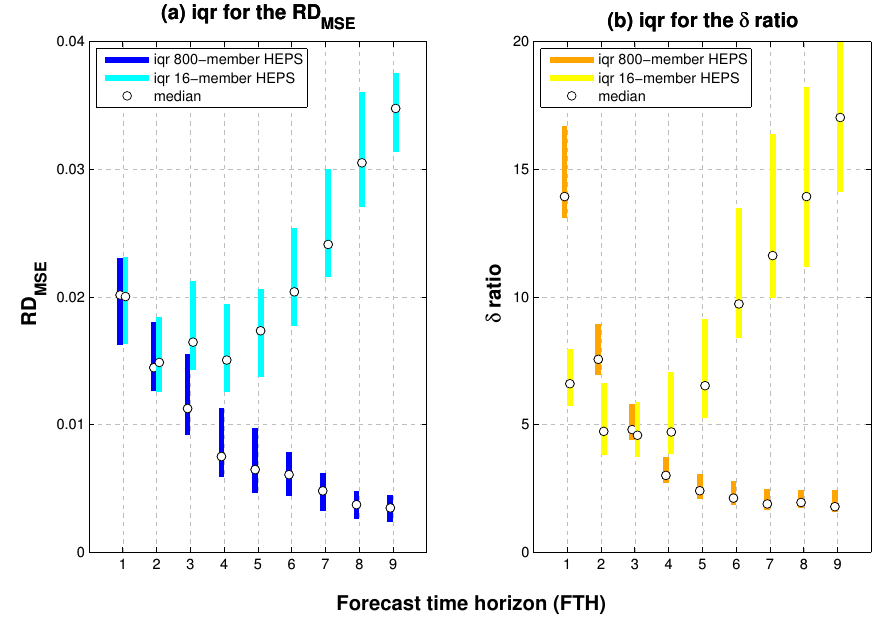
Fig. 3. Interquartile range (iqr) of RD MSE and δ ratio assessed in the 28 catchments under two HEPS schemes: 16-member HEPS (16 hy- drological models are driven by the deterministic forecast from ECMWF) and the 800-member HEPS (16 hydrological models are driven by the 50-perturbed member forecast from